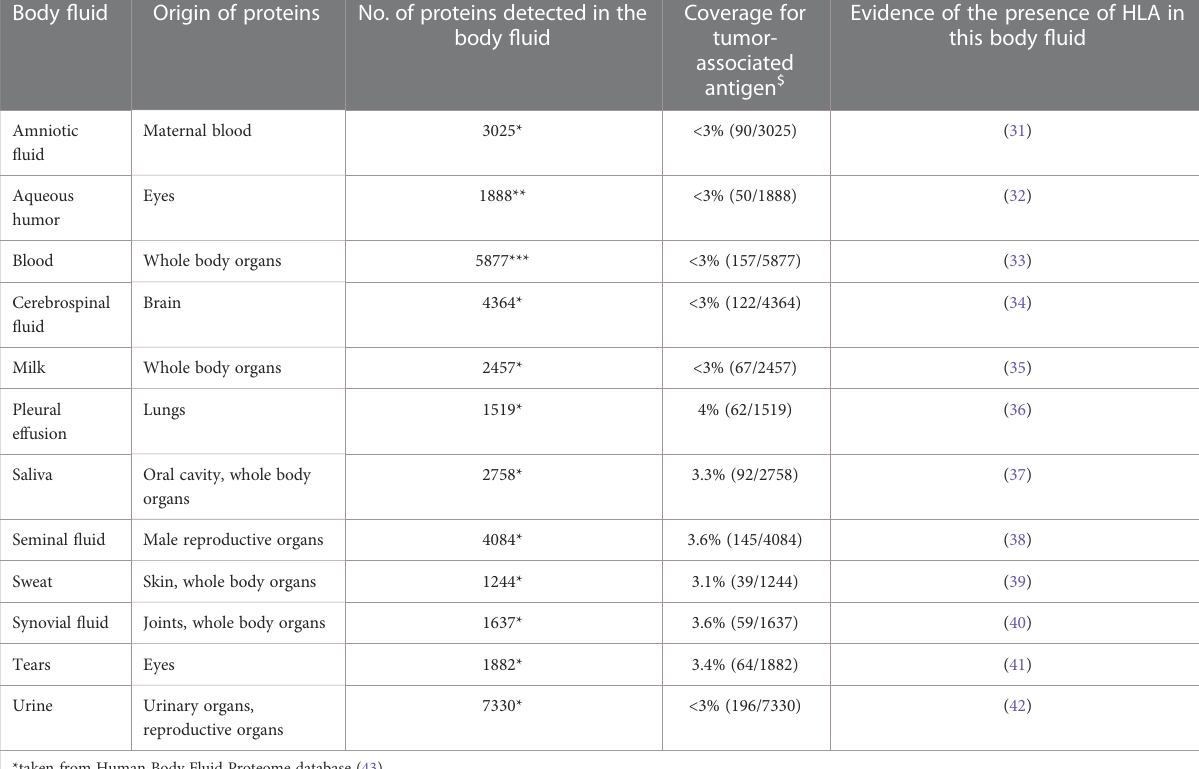
TABLE 1 Summary of various body fl uid in which presence of HLA has been validated via proteomics studies. Body fl